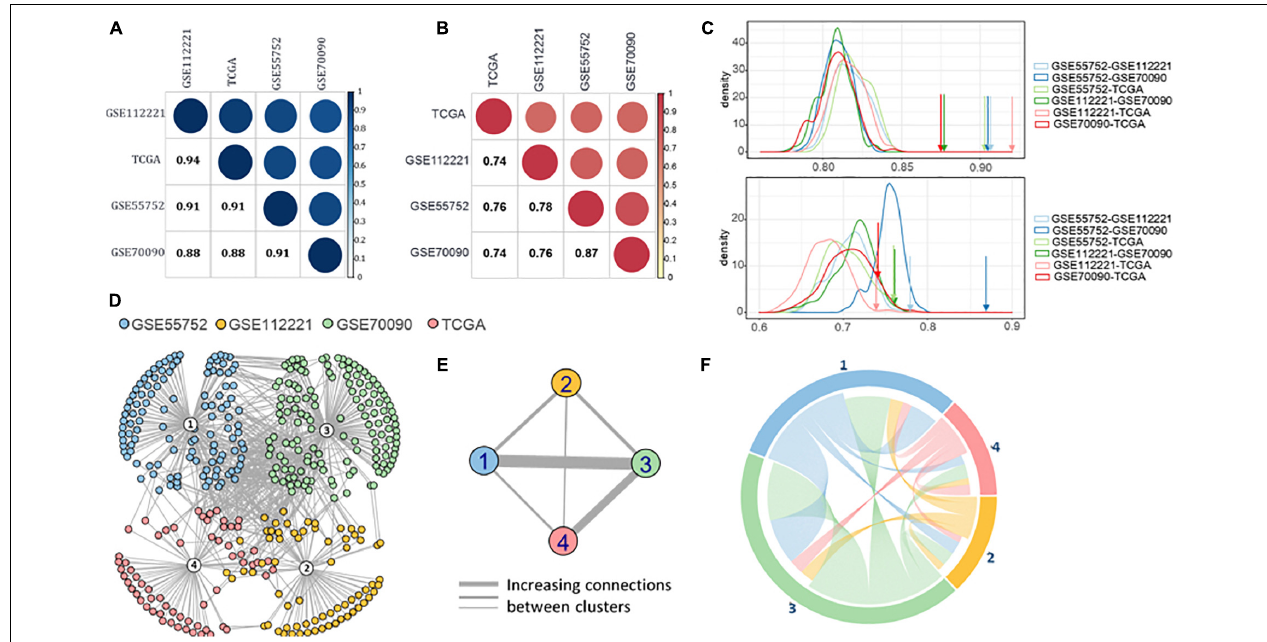
FIGURE 4 | (A) Semantic similarity of all the differential methylated genes from four datasets. (B) Semantic similarity of the differential methylated genes unique in four datasets. (C) Density of semantic similarity of two genes randomly picked up from two datasets. (D) Protein-protein association network of four datasets. (E) Connection across the four datasets. (F) Functional association between four